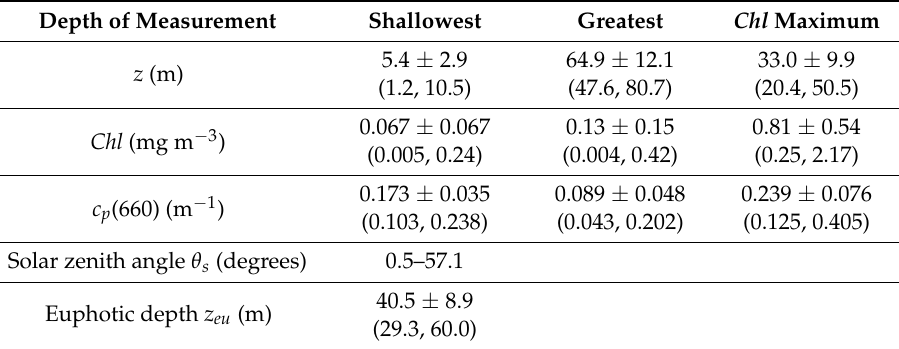
Summary of data characterizing the shallowest and greatest depths of radiometric measurements, the depth of chlorophyll- a maximum, and the corresponding chlorophyll- a concentration, Chl , and particulate beam attenuation coefficient at 660 nm, c p (660), for these depths based on all stations during the 2010 and 2011 cruises in the Gulf of California. For each of these variables the average value ± standard deviation with the minimum and maximum values in parenthesis are given. In addition, the minimum and maximum values of the solar zenith angle θ s and the data characterizing the euphotic depth z eu (the average value ± standard deviation with the minimum and maximum values in parenthesis) are shown for all